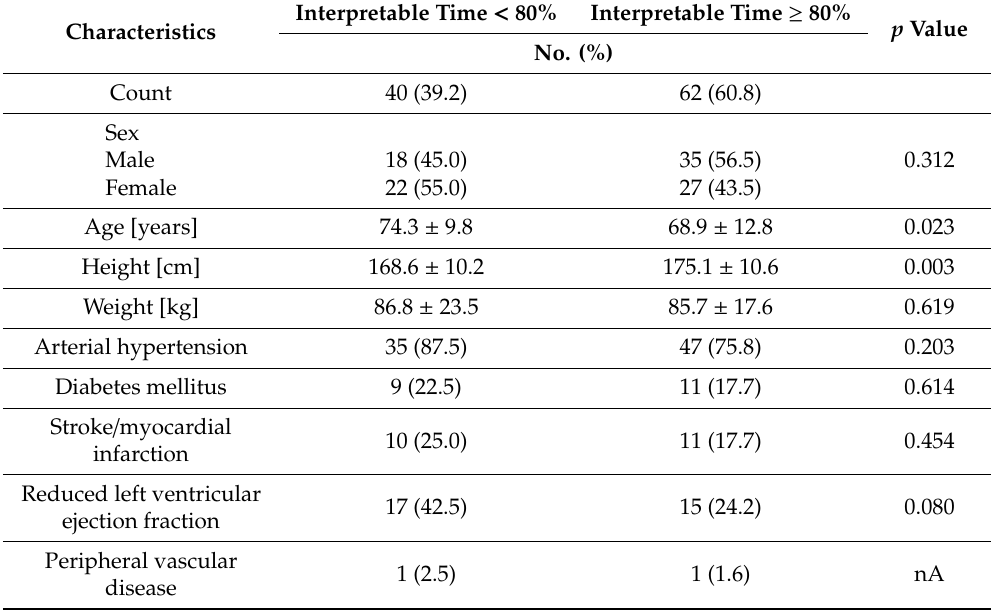
Table3. Differencesindemographics, medicalcharacteristics, concomitantmedication, andmeasurement conditions (below the bold line) of patients with interpretable time < 80% and ≥ 80%. (Significant di ff erences are marked in bold, Continuous variables are given as mean ±